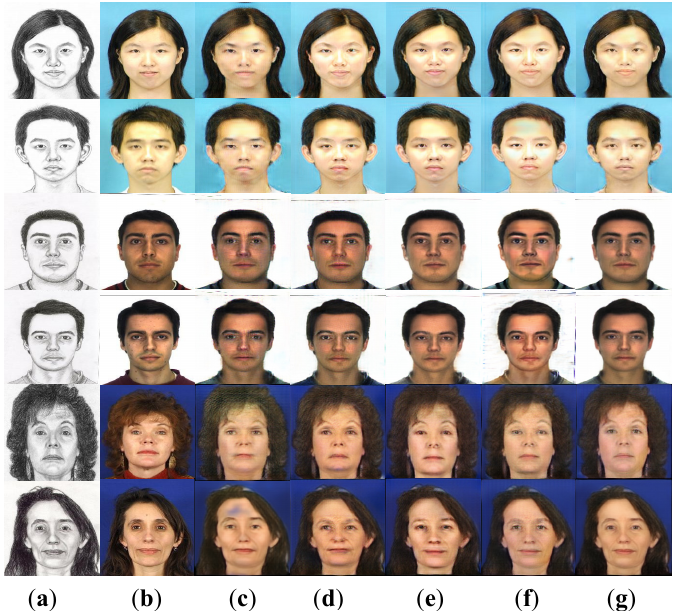
Figure 8. Comparison of synthetic results of ablation experiment: ( a ) Original sketch; ( b ) Real Photo; ( c ) CycleGAN; ( d ) CycleGAN w/MFEM; ( e ) CycleGAN w/CBAM-R; ( f ) CycleGAN w/Multi-level cycle loss; ( g )